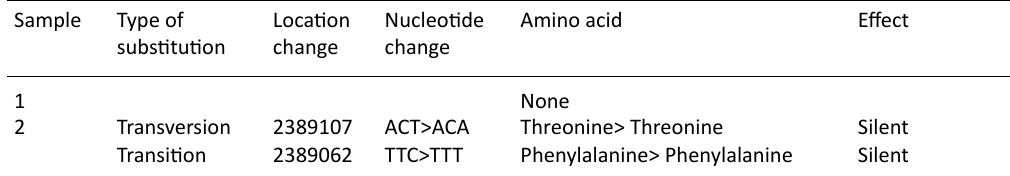
table 3. Polymorphism of hpmB gene sequence